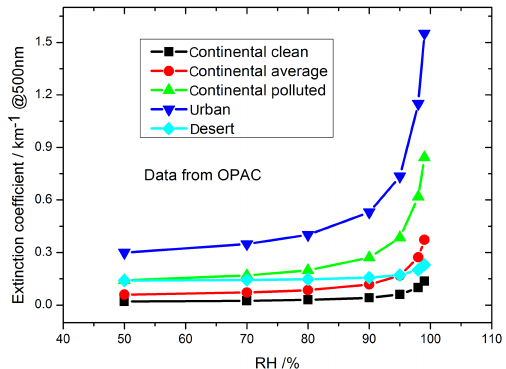
Figure 2. The relationship between aerosol extinction coefficient and atmospheric relative humidity (RH) for five types of